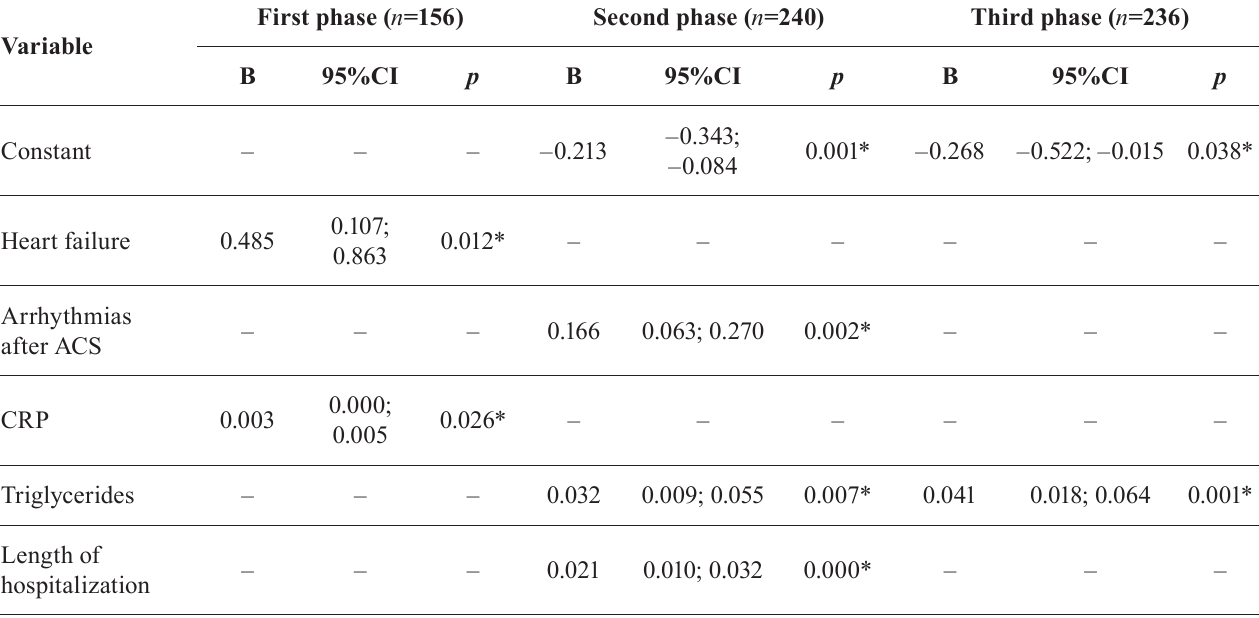
TABLE IV - Risk factors for statin potential drug-drug interactions in acute coronary syndrome patients across phases of treatment